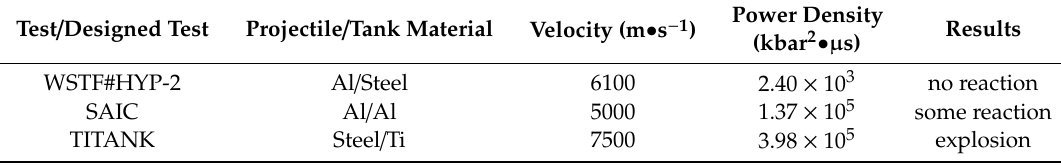
Figure 1. Flow chart for judging the damage consequences of a satellite tank under debris hypervelocity impact. Table 1. Conditions and results of hypervelocity impact test on liquid hydrazine [8].